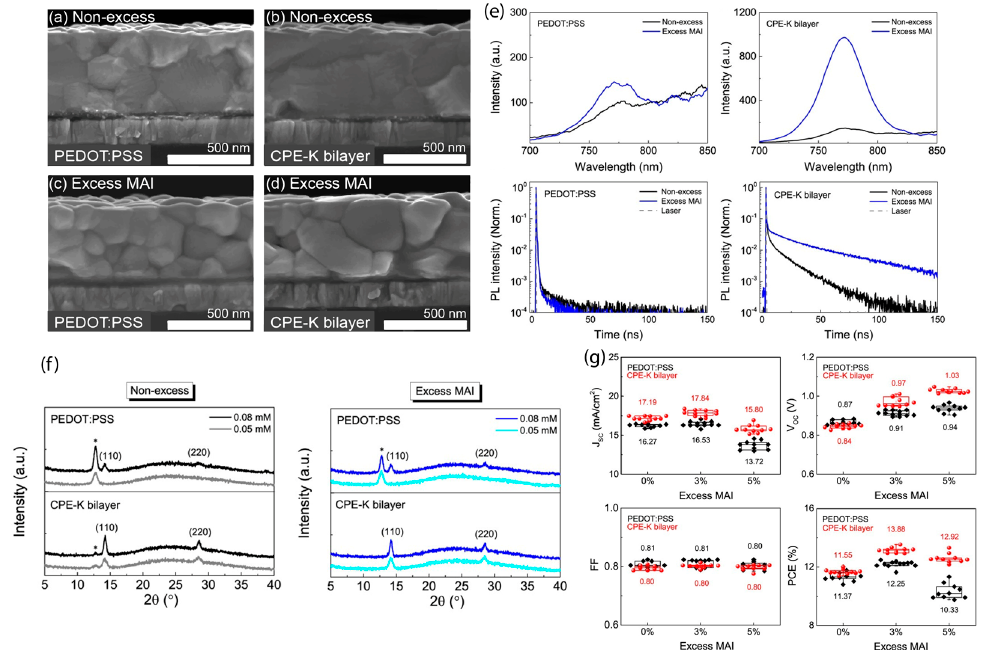
Figure 4. Interfacial crystallinity. ( a – d ) Top − view SEM images (scale bar 500 nm). ( e ) PL spectra and time ‐ resolved PL spectra of perovskite films with PEDOT:PSS and CPE − K bilayer with excess and non ‐ excess MAI. ( f ) XRD patterns of perovskite films formed from precursor solutions with different molar concentrations of PbI 2 in DMF for non ‐ excess (0%) and 5% excess MAI. The diffraction peak for the (001) plane of PbI 2 is denoted by an asterisk. ( g ) Device performance for perovskite films with PEDOT:PSS and CPE − K bilayer with excess MAI [86]. Reprinted with permission.